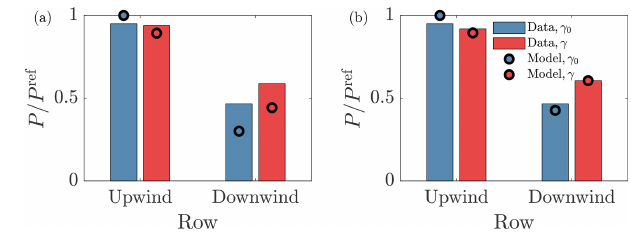
Figure 12. Comparison of LES row-averaged power data and wake model predictions for the closed-loop (Case OUU-F) and lookup table (Case L) wind farm control methodologies for the stable strat- ification regime. (a) Lookup table control data and predictions. (b) Closed-loop control data and predictions. Baseline yaw-aligned control results are indicated with γ 0 , and wake steering results are indicated with γ . The upwind row is an average of turbines 1, 3, and 5. The downwind row is an average of turbines 4, 6, and